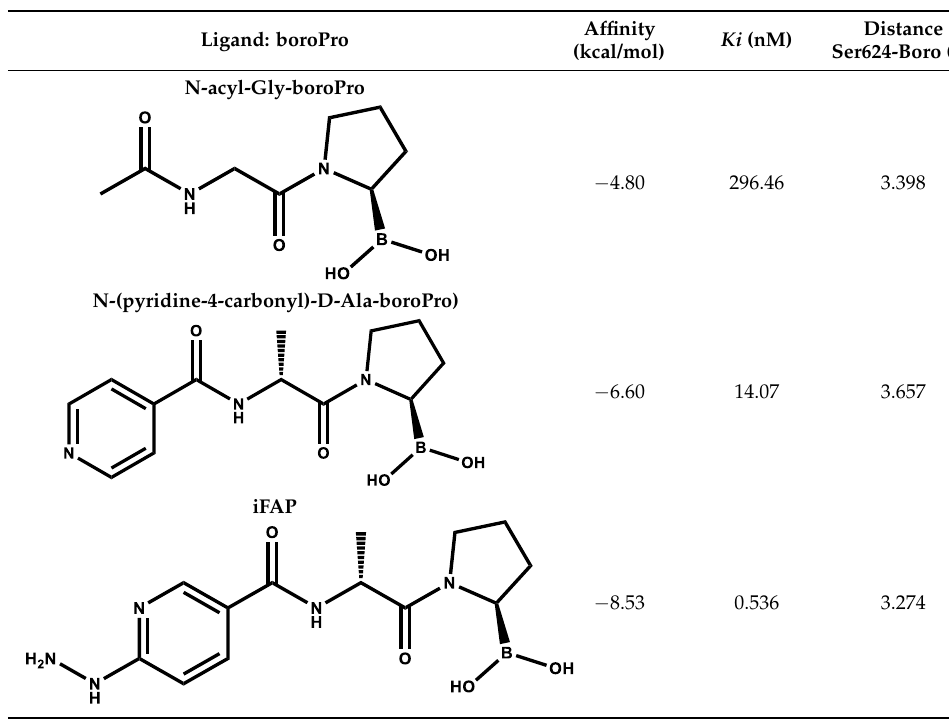
Table 1. Affinity scores determined by molecular coupling (AutoDock), as well as the inhibition constants ( Ki ), and interaction distance between the boron residue and Serine 624 of the fibroblast activation protein (FAP) for each boroPro ligand.